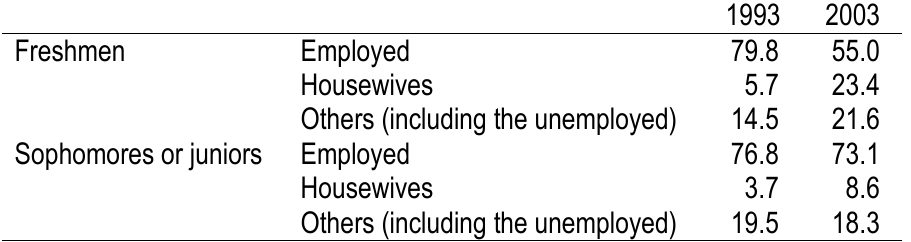
Table 6. Compositions of the newly enrolled students by the occupational